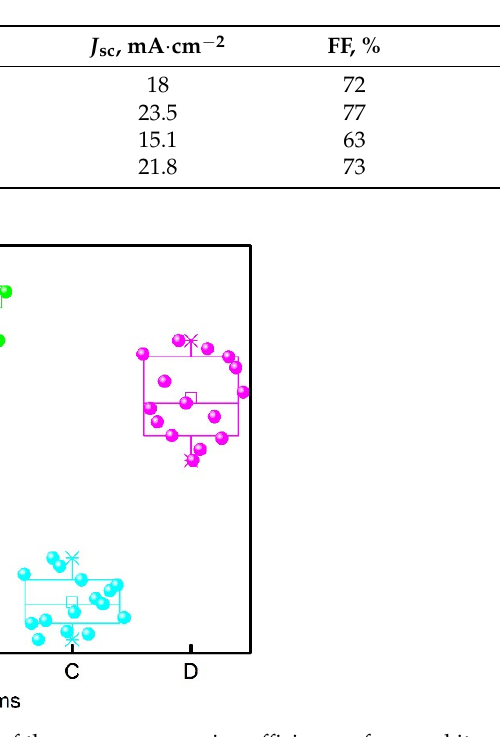
Figure 11. Statistical distribution of the power-conversion efficiency of perovskite solar cells based on different perovskite films.